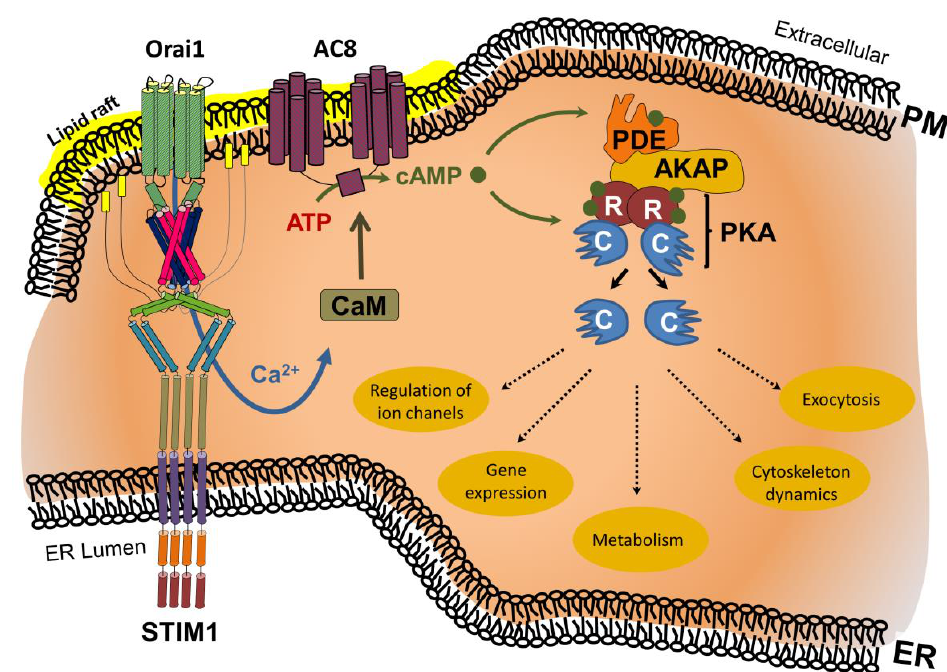
Figure 2. ER store depletion-induced Ca 2+ influx triggers Ca 2+ /calmodulin (CaM)-mediated activation of adenylcyclase 8 (AC8) within lipid rafts. The resulting cAMP binds to the regulatory unit (R) of protein kinase A (PKA), resulting in the release of the PKA catalytic unit (C), and enabling regulation of ion channels, gene expression, metabolism, cytoskeleton dynamics, or exocytosis. Excess cAMP is broken down by phosphodiesterases (PDE). The range and selectivity of the cAMP-mediated biological effect is regulated by A-kinase anchoring protein (AKAP) through linkage of PKA and PDEs. Additional abbreviations: ER, endoplasmic reticulum; PM, plasma membrane.